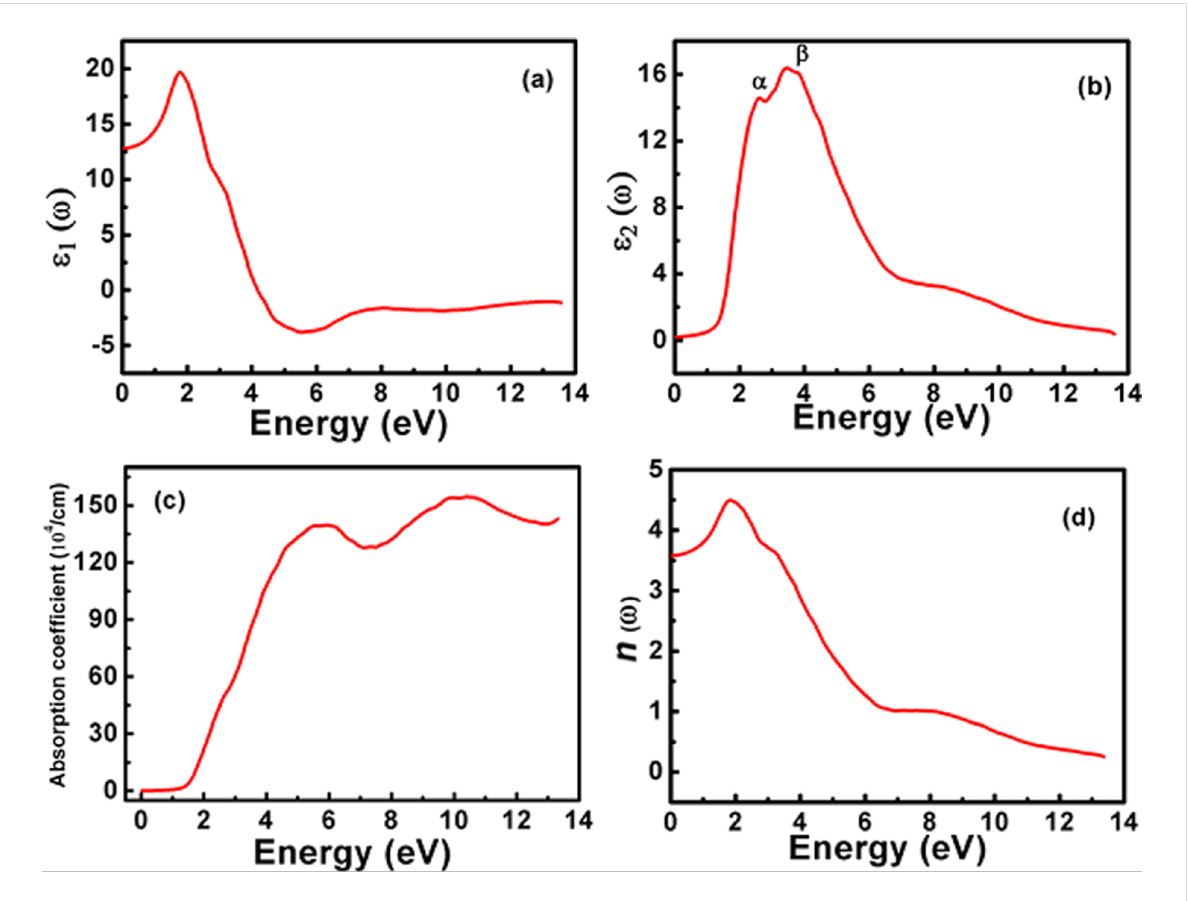
Figure 11: Variation of the (a) real ε 1 ( ω ) and (b) imaginary ε 2 ( ω ) parts of the dielectric function. (c) The absorption coefficient spectra α ( ω ) and (d) the refractive index n ( ω ) as a function of energy for the cubic π -SnSe alloy, computed within the independent particle approximation centered on single- particle electronic eigenvalues obtained from the Tb-mBJ